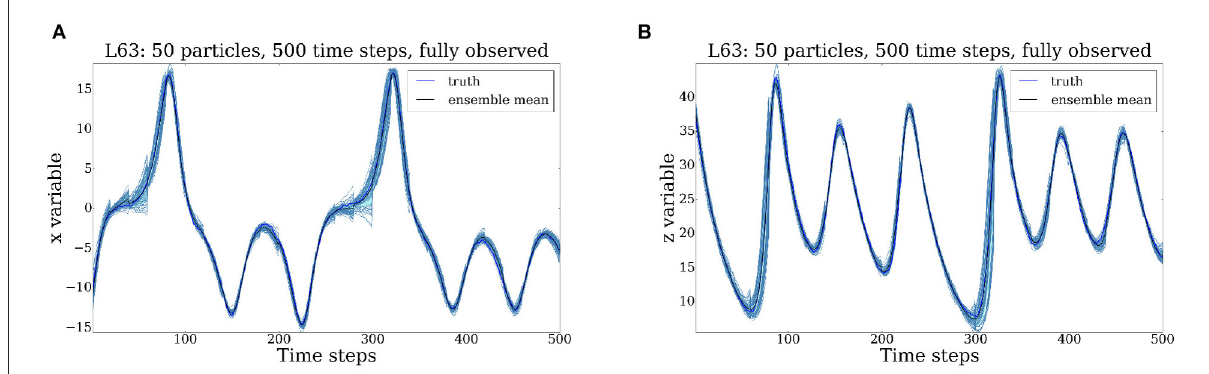
FIGURE5 Evolution of the Lorenz ’63 model for 500 time steps, all 3 variables are observed every 20 time steps. The initial uncertainty and the observational uncertainty are both equal to 1, the model error is equal to 0.1. Uncertainty is substantially reduced at assimilation times. (A) x variable. (B) z variable.